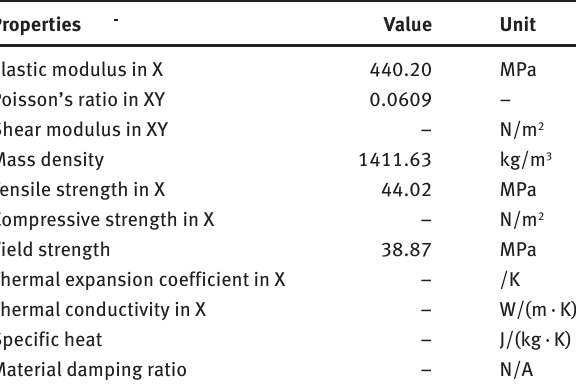
Table 14: HA-PLA composite properties.